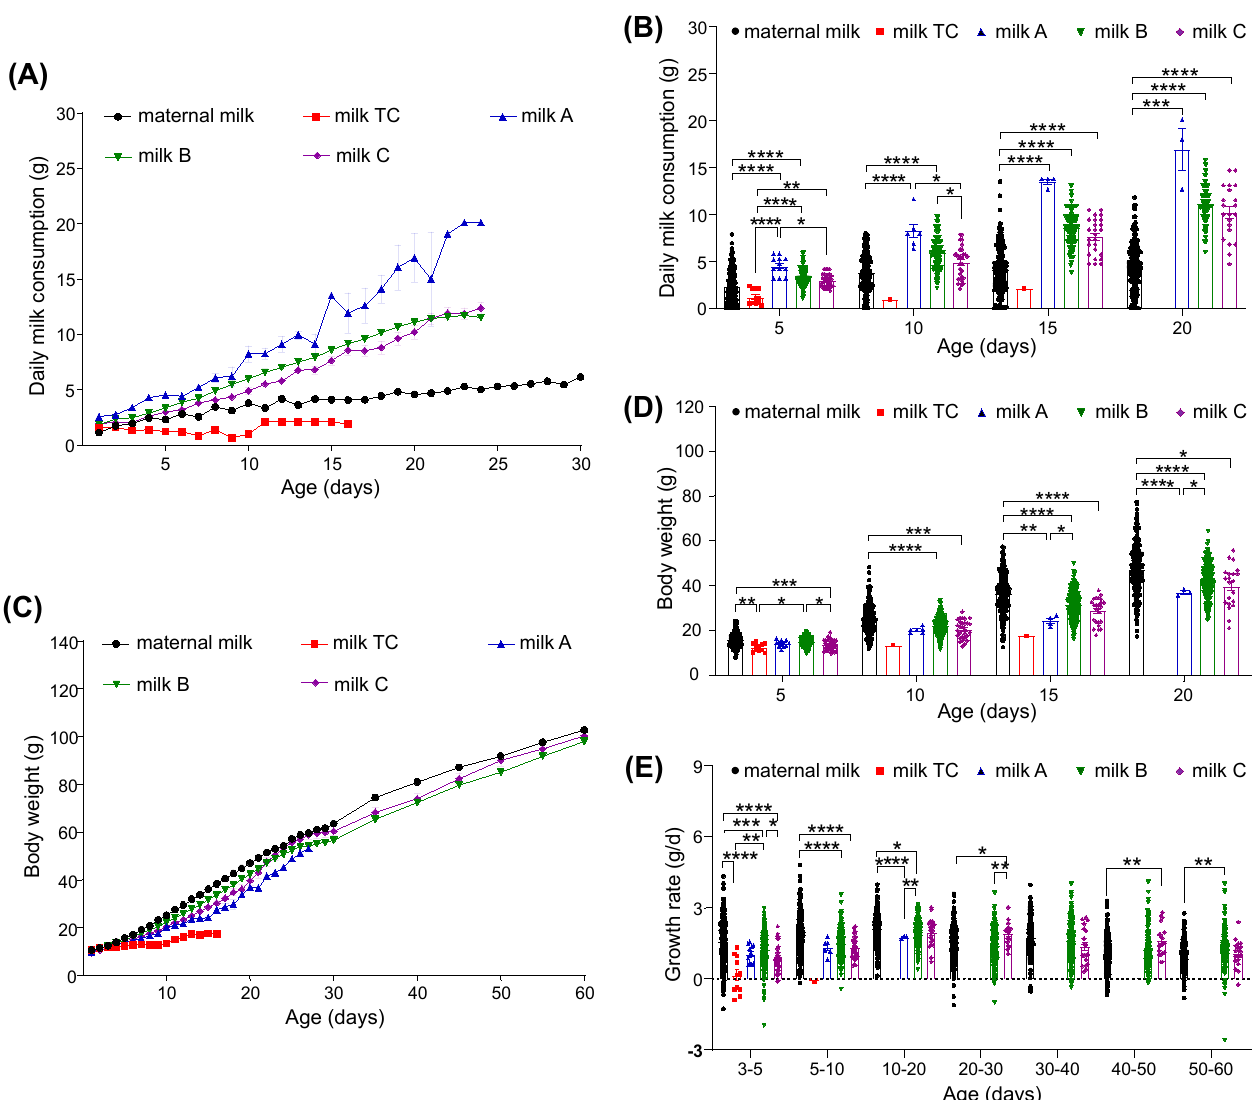
Figure 3. Daily milk consumption and growth of Chinese tree shrew pups fed with different types of milk. ( A ) Daily consumption of milk before the introduction of solid food powders. Maternal milk, n = 224; milk TC, n = 22; milk A, n = 12; milk B, n = 214; and milk C, n = 35. A total of 41 pups fed with maternal milk, all 22 pups fed with milk TC, 11 pups fed with milk A, 30 pups fed with milk B, and 16 pups fed with milk C died at different ages during the measurement period. ( B ) Daily milk consumption by pups on postnatal days 5, 10, 15, and 20. ( C ) Growth curve of the Chinese tree shrew pups. A total of 49 pups fed with maternal milk, all 34 pups fed with milk TC or milk A, 33 pups fed with milk B, and 17 pups fed with milk C died at different ages during the test. ( D ) Body growth of tree shrew pups on postnatal days 5, 10, 15, and 20. ( E ) Growth rate of the pups during postnatal days 3–5, 5–10, 10–20, 20–30, 30–40, 40–50, and 50–60. * p < 0.05, ** p < 0.01, *** p < 0.001, **** p < 0.0001. Values are presented as the mean ± SEM.